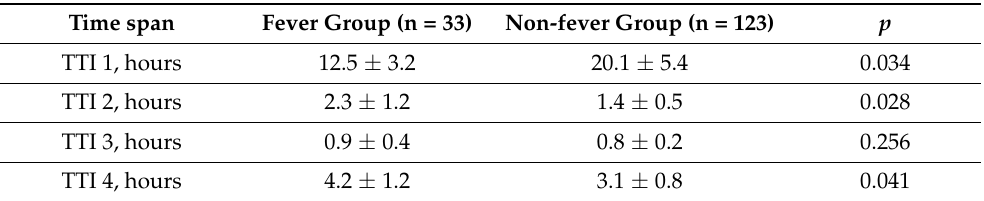
Table 2. Comparisons of TTIs between fever group and non-fever group for pediatric patients with intussusception during the COVID-19 pandemic (in 2020 and 2021).